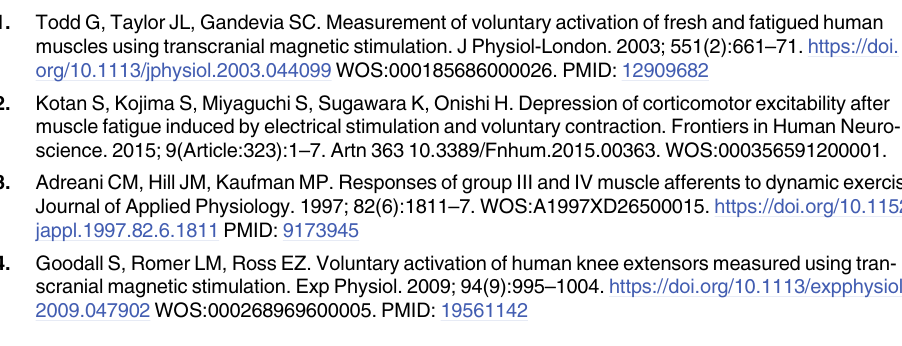
S1 Table. Means ± Standard Deviations of torque recorded during voluntary contractions (100%, 87.5%, 75%, 62.5%, and 50% of MVC) and TMS-evoked superimposed twitches during the 5-C NMA performed before and after a fatiguing task. S1 Fig. Example of a curvilinear relationship for one